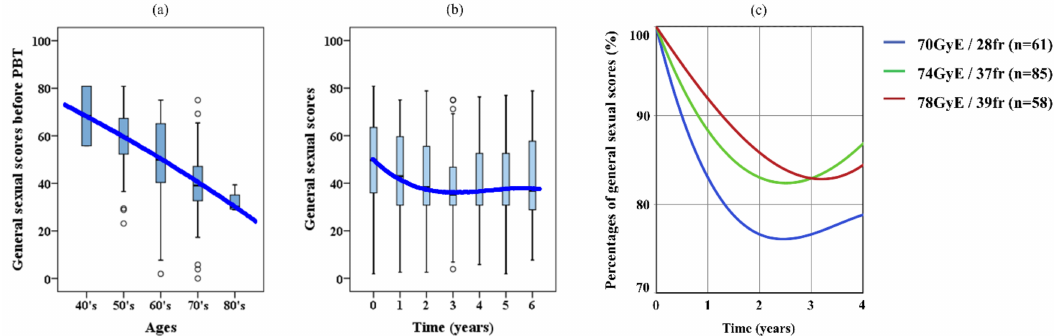
Figure 3. ( a ) Aging variation of general sexual scores in the expanded prostate cancer index composite. ( b ) Chronological variation of scores after proton beam therapy. ( c ) Approximate curves expressed as percentages after proton beam therapy in each